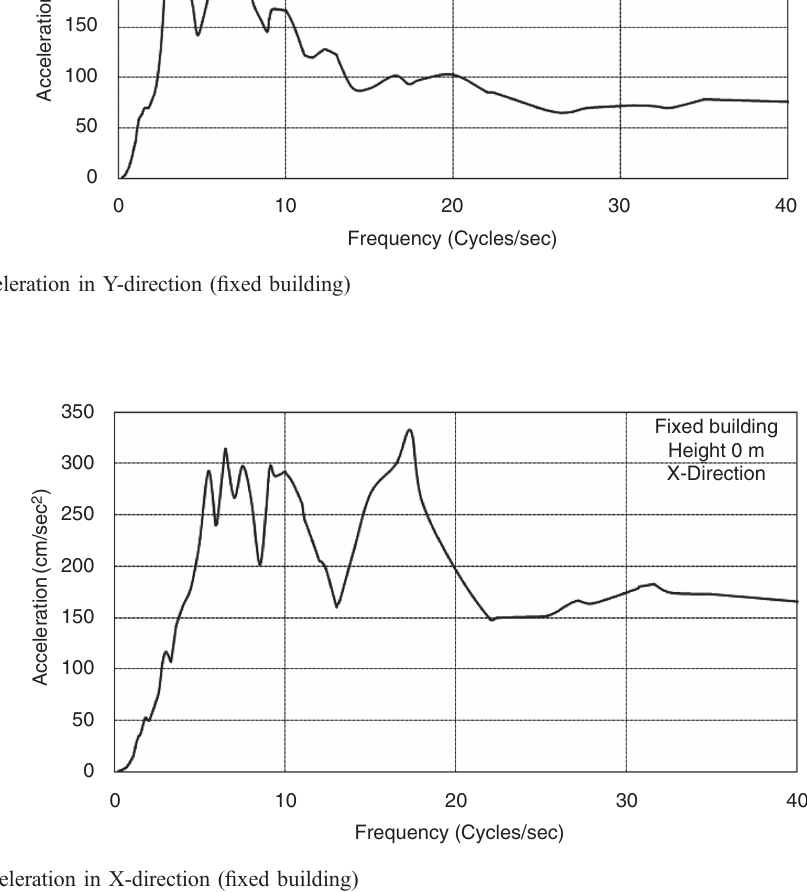
Fig. 8. Spectral Acceleration in X-direction ( fi xed building)